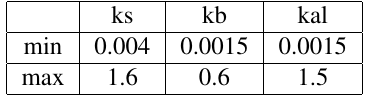
Fig. 5. Dependency of entry time on bending